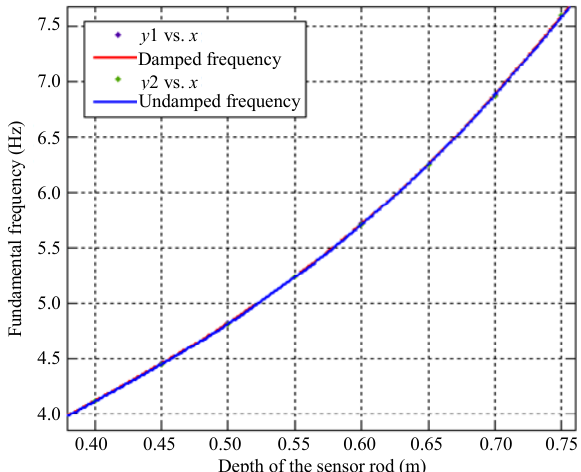
Fig. 4 Frequency comparison of damped and undamped